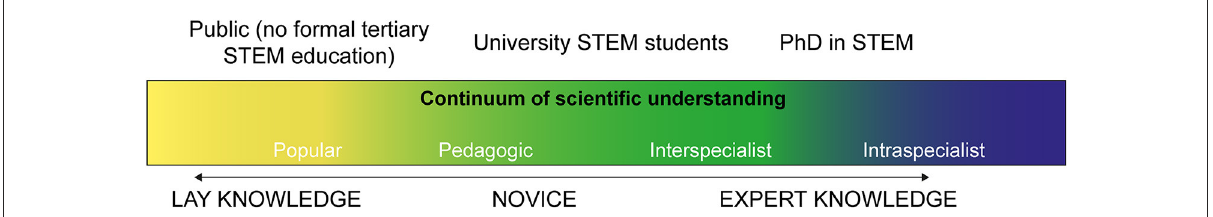
FIGURE1 An integrated model of the pedagogic–scicomm continuum, showing stakeholders, the various levels at which science can be transferred, and kinds of knowledge that can be incorporated. Different stakeholders tend to fall at different points across the gradient, but it is important to recognise that they never form discrete and separated groups (drawn using concepts from Cloître and Shinn, 1985; Bucchi, 2008; Petcovic and Libarkin,